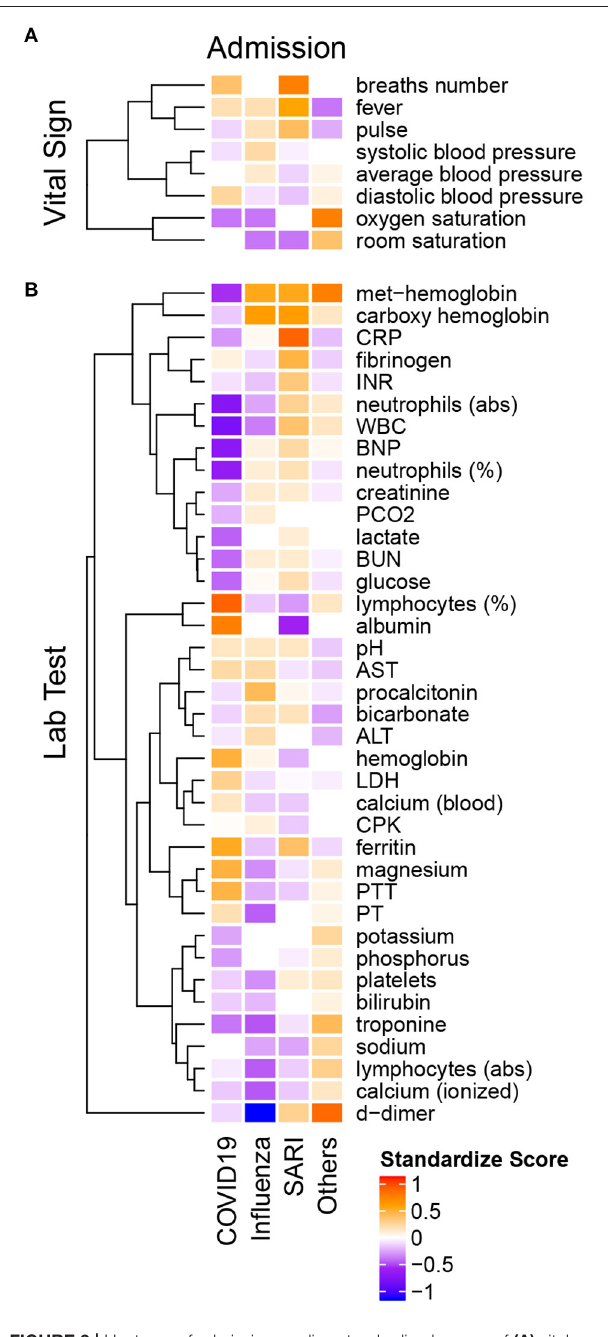
FIGURE 3 | Heatmap of admission median standardized scores of (A) vital signs and (B) lab tests in COVID-19, influenza A/B, SARI and Others. All variables are introduced on the same scale, relative to the variable overall median. The standardized scores is positive if the group median is greater than the overall median (orange-red) and negative otherwise (purple-blue). Hierarchical clustering on the left points to groups with similar pattern across diseases.